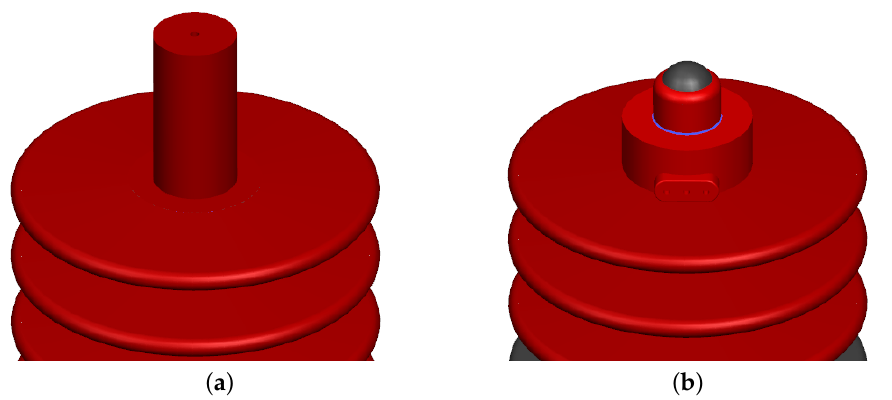
Figure 3. Structural comparison diagram of SMTS and the original multi-compression structure: